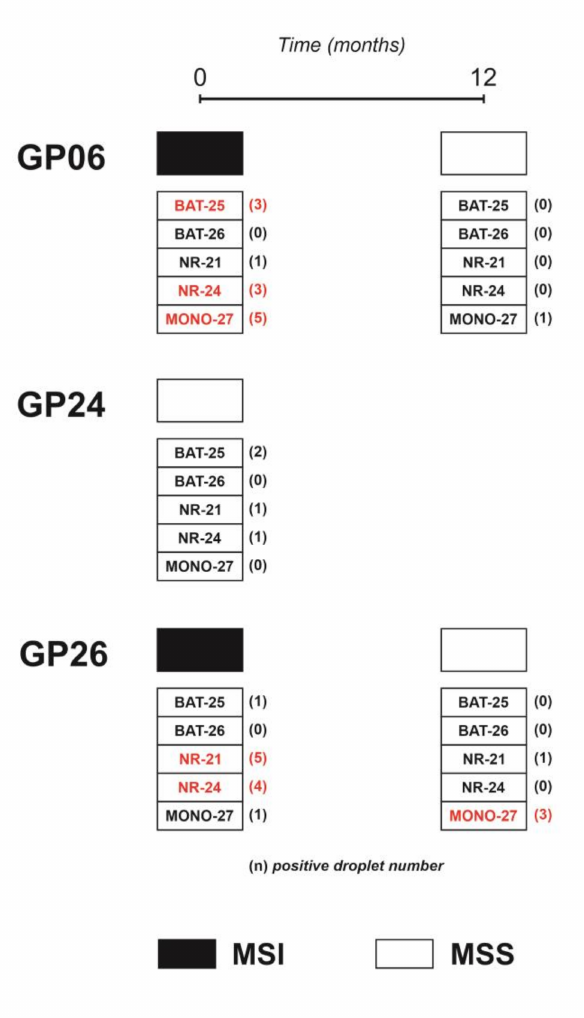
Figure 4. MSI status in cfDNA samples of GP06, GP24 and GP26 prospective patients. Black and white rectangles indicate MSI or MSS status, respectively. Unstable microsatellites are shown in red and the number of positive droplets is indicated in